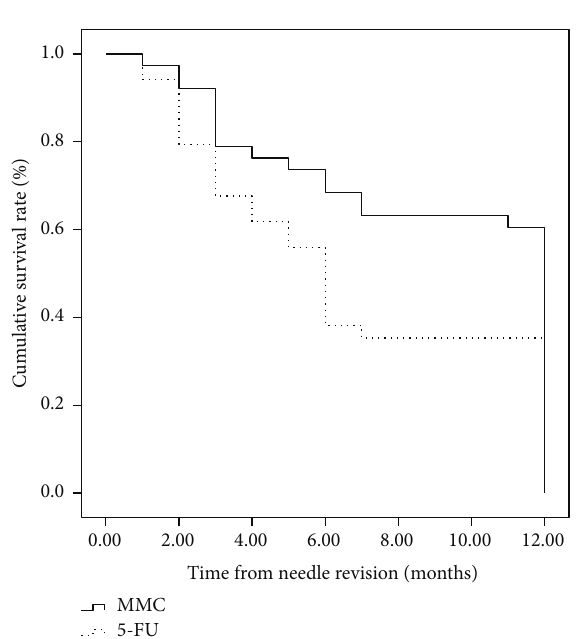
Figure 2: Survival curve with complete success defined as 5 < IOP < 21mmHg without glaucoma medication ( 𝑃 = 0.042 ).